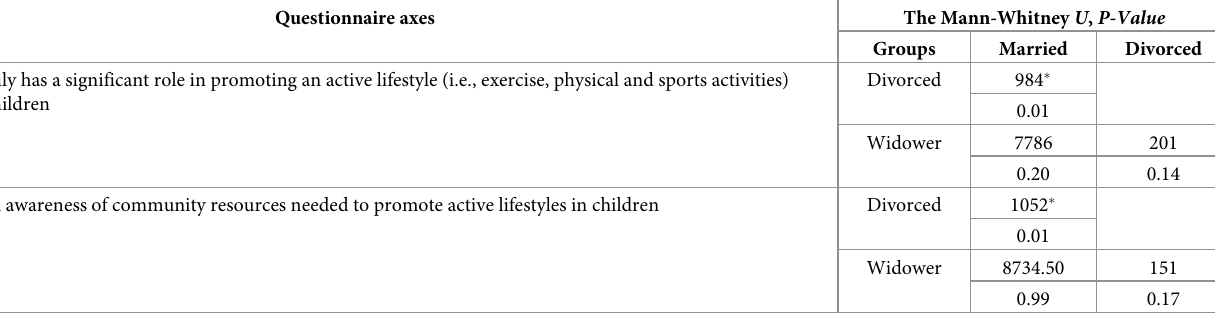
Table 5. The Mann-Whitney test to determine the significant difference in the mean of sample‘s responses among each pair group according to Parent‘s Marital status. Questionnaire axes